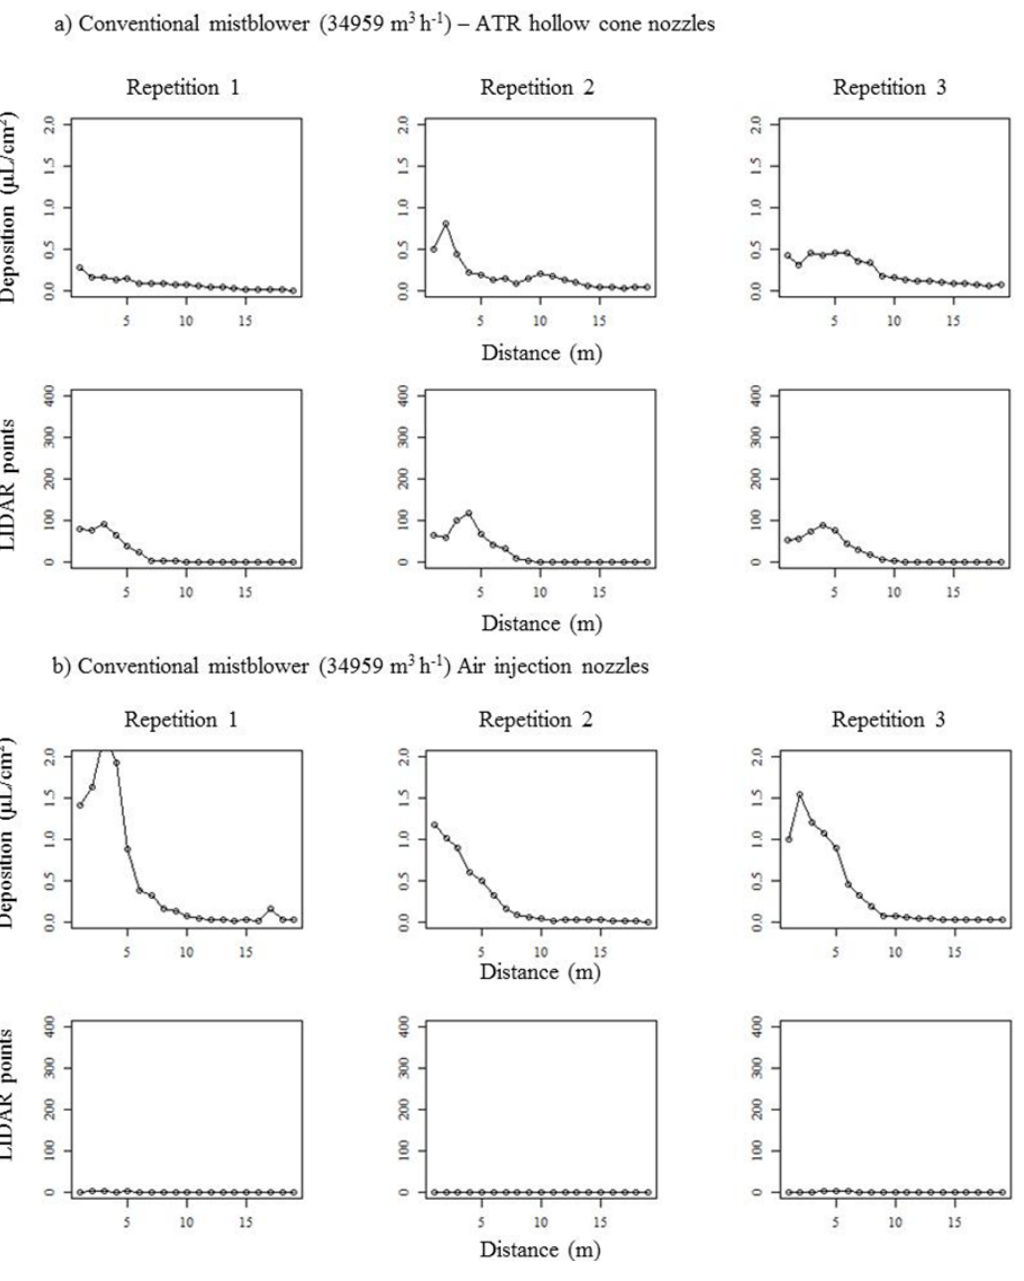
Figure 11. Curves of spray deposit (test bench and LIDAR) obtained with conventional mistblower at high air flow rate. Part ( a ) represents to conventional hollow cones and part ( b ) represents to air injection